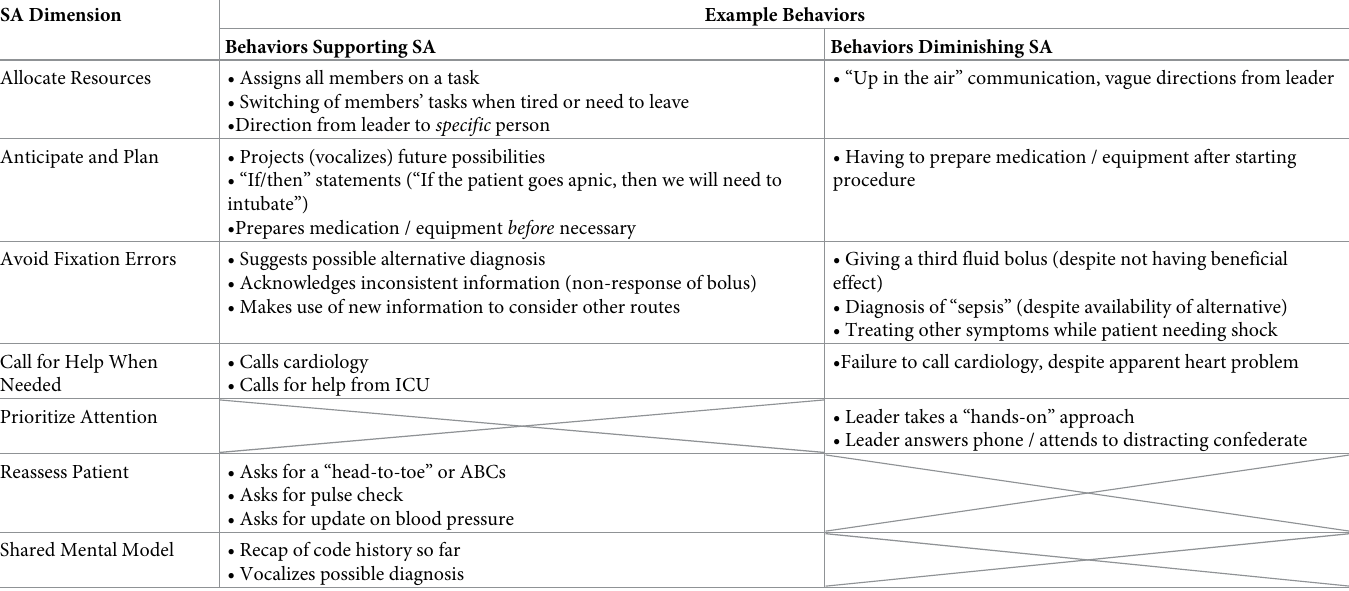
Table 3. Example behaviors scored on dimensions of